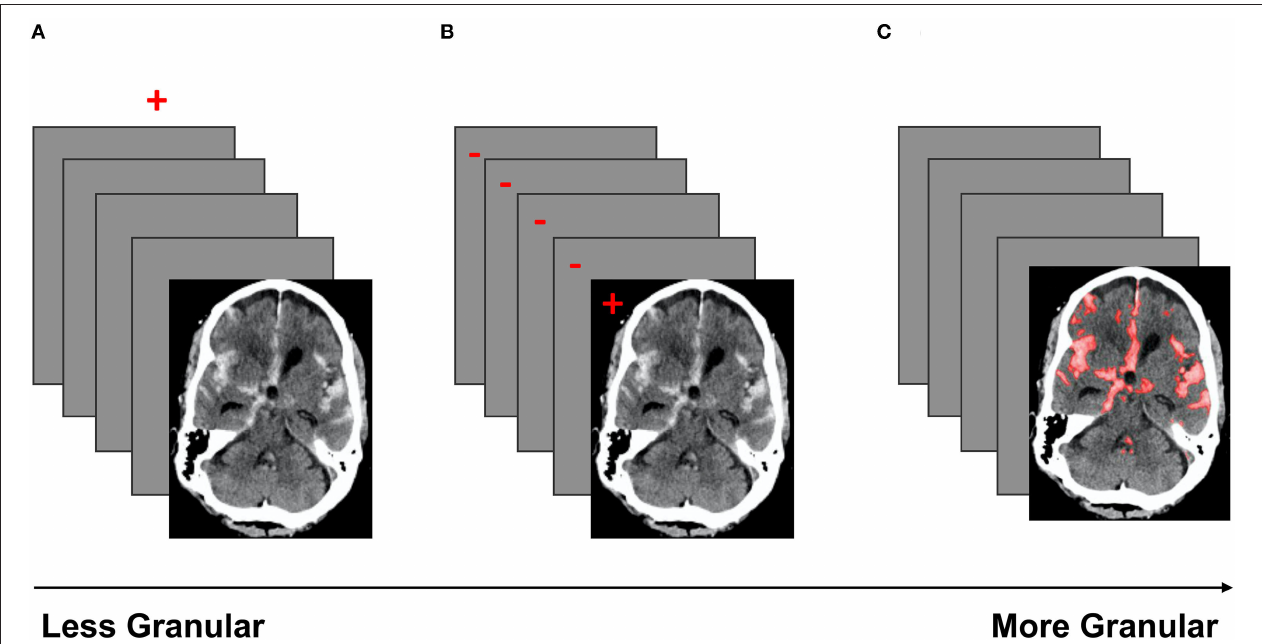
FIGURE 4 | A schematic of three labeling strategies in order of increasing granularity. Red indicates the label(s). (A) Demonstrates examination labels, in which an entire exam is annotated as “positive” or “negative” for a given pathology. (B) Demonstrates image labels, where each image in a stack is annotated as “positive” or “negative” for a pathology. (C) Demonstrates pixel labels, where all pixels in the exam are labeled as “positive” or “negative” (